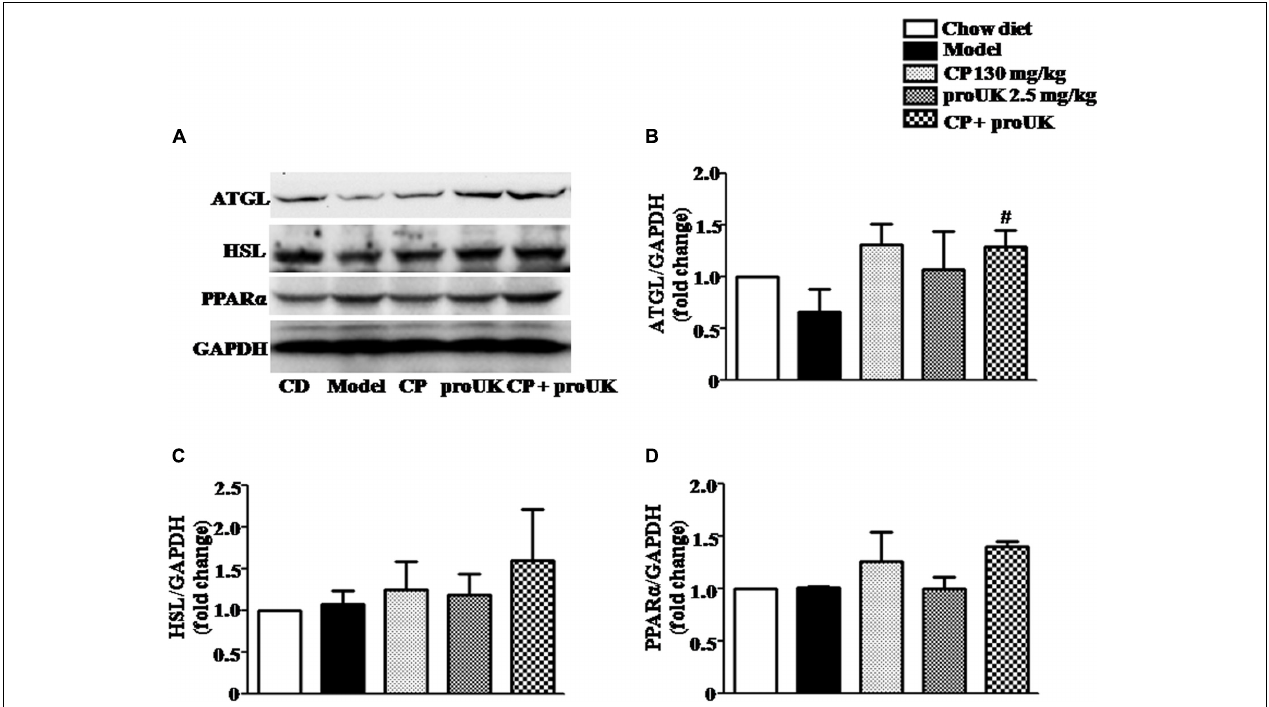
FIGURE 6 | Effect of treatment with CP plus proUK on the expression of hepatic triglyceride metabolism-related proteins in the liver. (A) Western blot of the liver protein levels of ATGL, HSL and PPAR α . (B) The quantitative analysis of ATGL expression in the liver from different groups. (C) The quantitative analysis of HSL expression in the liver from different groups. (D) The quantitative analysis of PPAR α expression in the liver from different groups. Data are presented as the mean ± SEM. n = 5. # P < 0.05 vs. Model